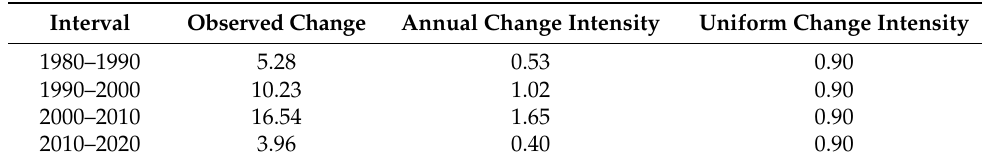
Table 17. Interval-level Change Intensity.